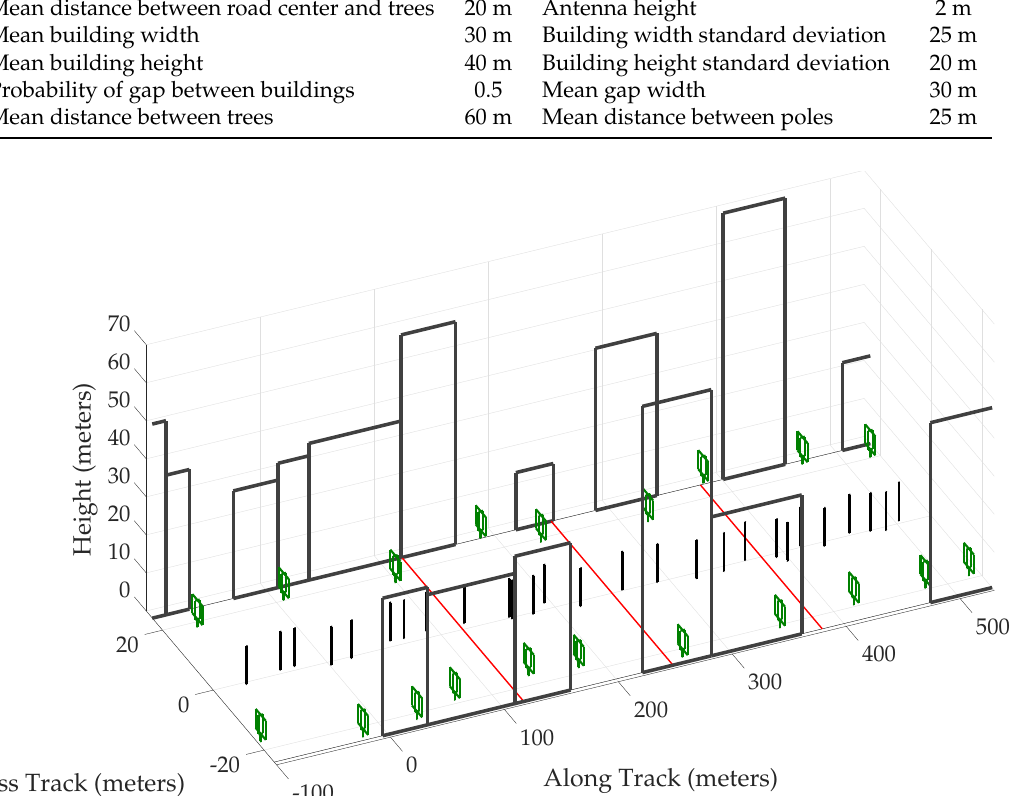
Figure 3. Initial segment of the simulated urban corridor. Red lines across the road denote the positions where the vehicle is momentarily